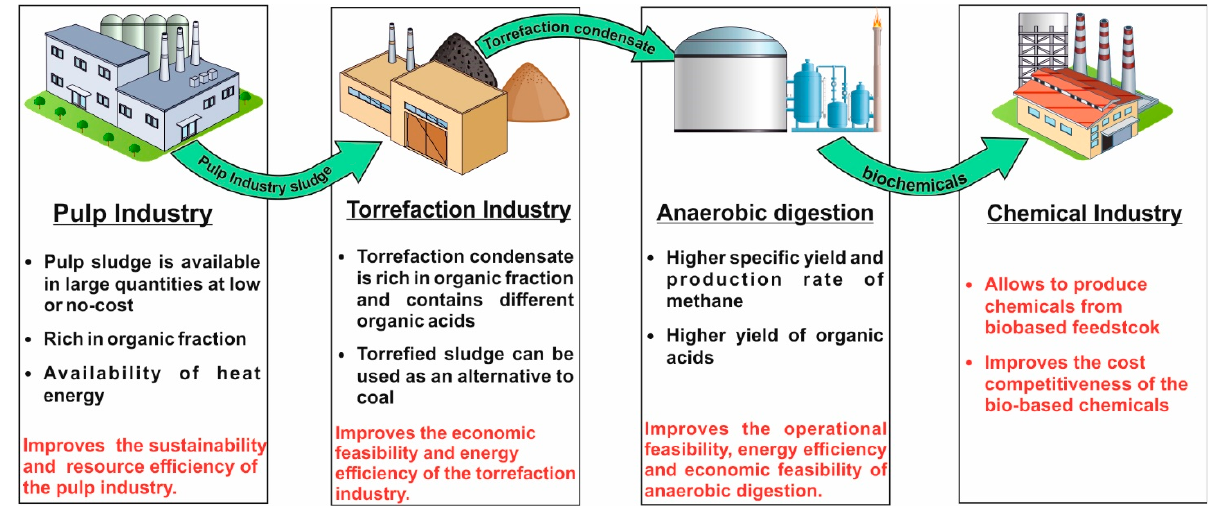
Figure 5. The industrial symbiosis between different biomass and/or organic residues valorization industries under the concept of anaerobic digestion of pulp sludge derived torrefaction condensate.